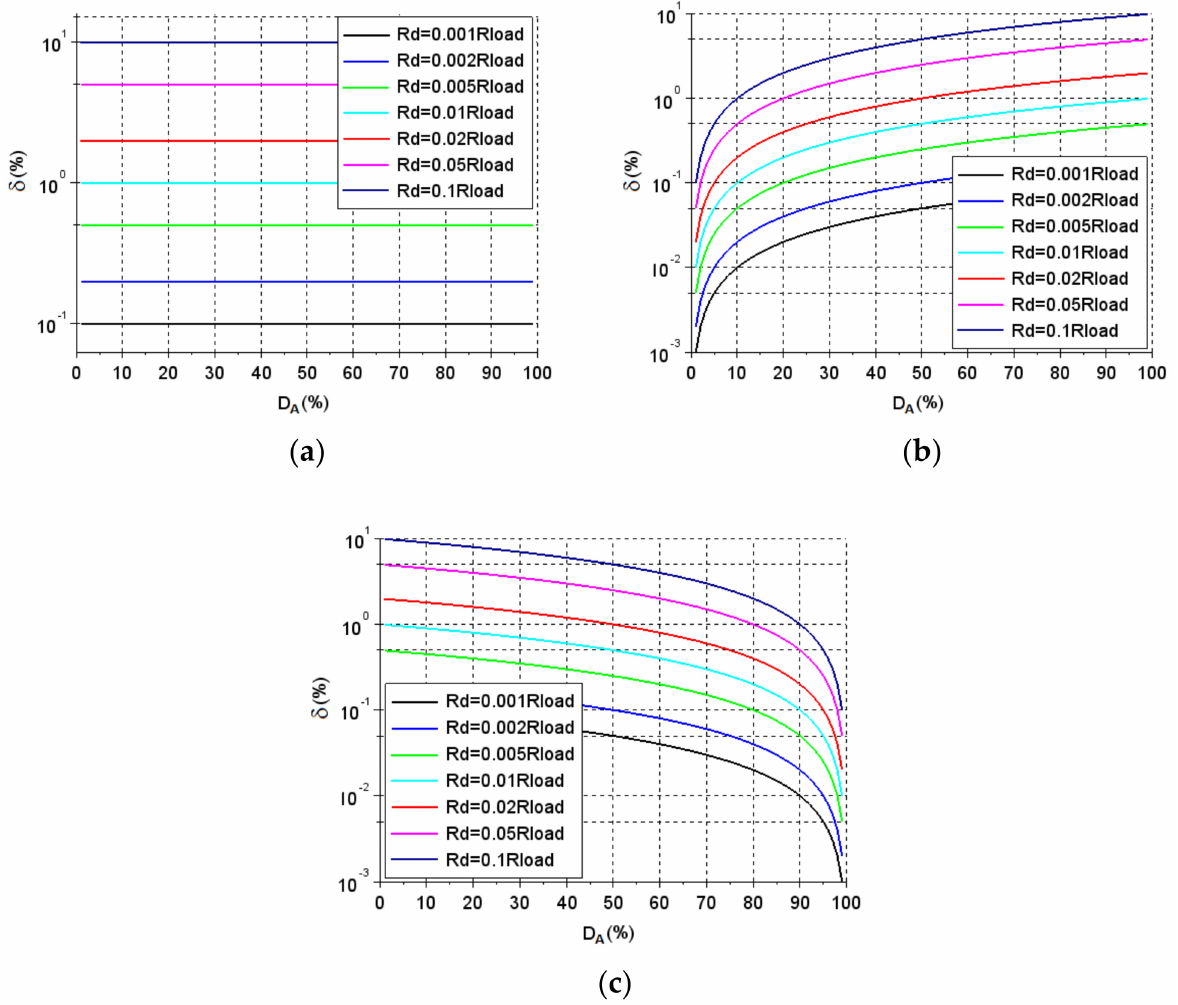
Figure A1. Influence of a specific parasitic resistance on the input resistance of a buck converter, for different duty cycle values. The figures represent a percentage error calculated with Equation (A1) for different values of: ( a ) inductor resistance R L ; ( b ) transistor resistance R T ; ( c ) diode resistance R D